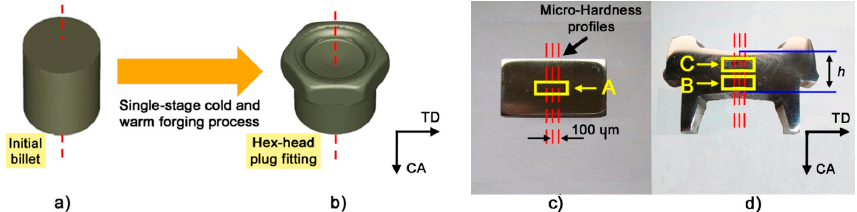
Figure 2. CAD geometry of: initial billet ( a ); and hex-head plug ( b ); and longitudinal sections of: real billet ( c ); and forged component ( d ).